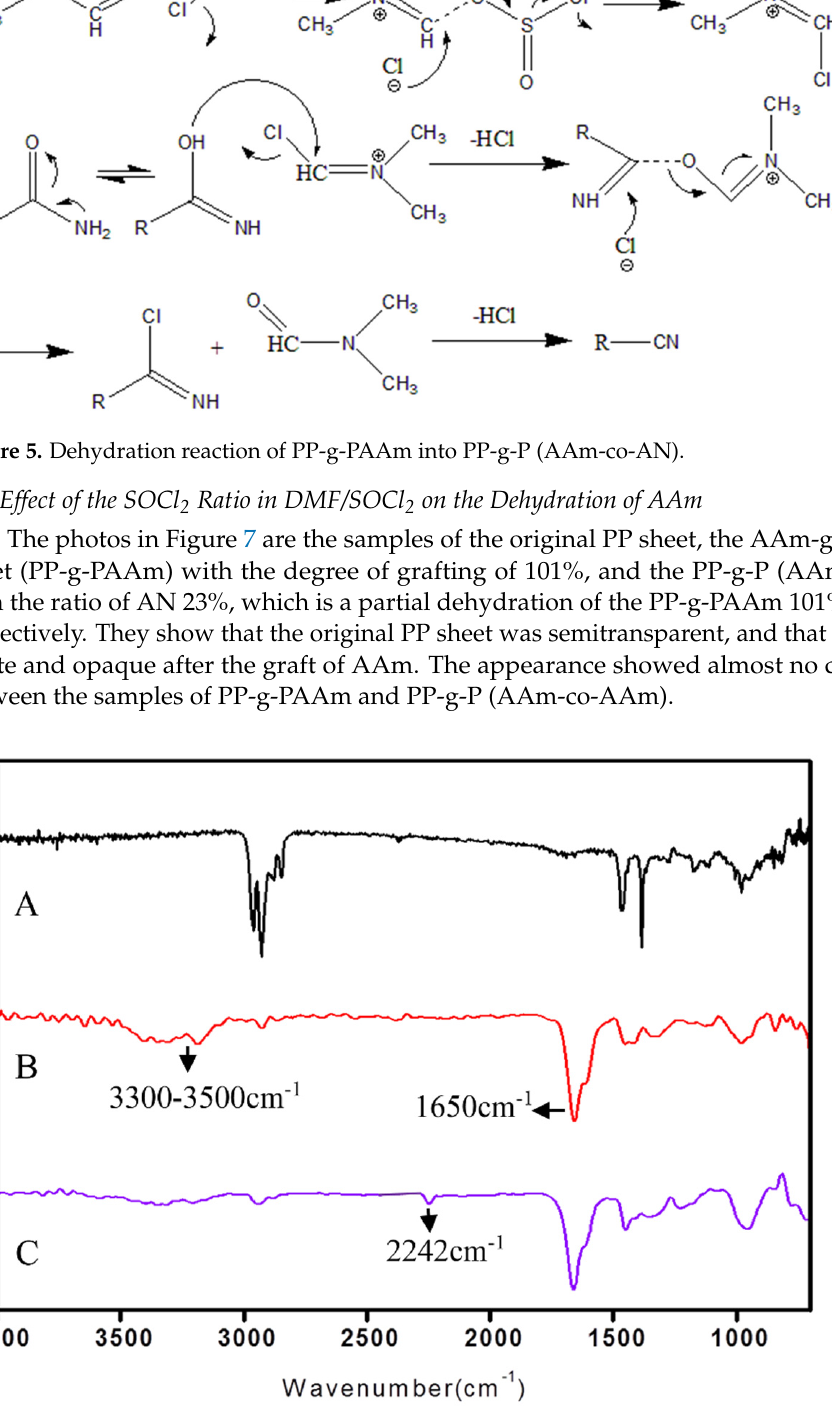
Figure 5. Dehydration reaction of PP ‐ g ‐ PAAm into PP ‐ g ‐ P (AAm ‐ co ‐ AN).